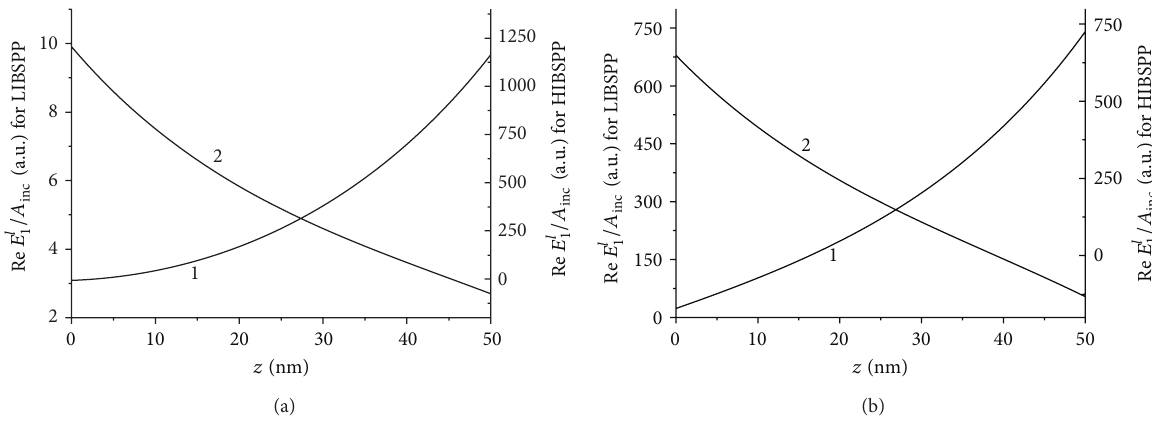
Figure 8: The normalized real part of the longitudinal component 𝐸 𝑙 1 of electric vector of low-index (1) and high-index (2) TM0 Bessel surface plasmon polariton versus the distance inside the 50 nm gold film separating the SF10 glass and air (a) or fluid with refractive index 1.33 (b). The distance from the Bessel surface plasmon polariton axis is 𝜌 = 0 , and the wavelength is 𝜆 = 0.633 𝜇